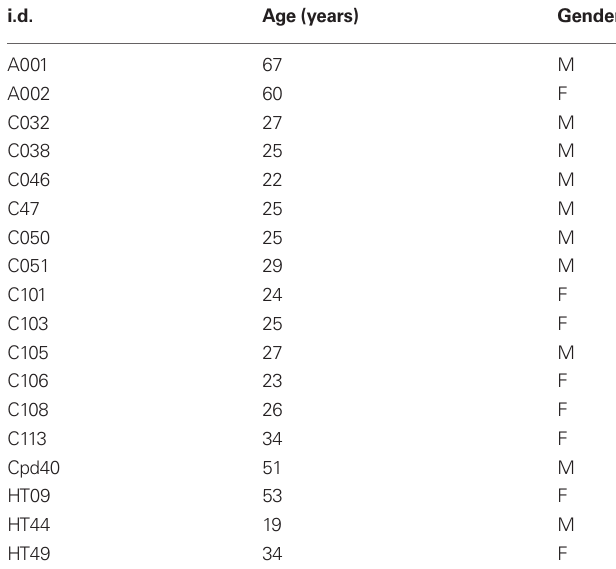
Table 2 | Control subjects demographics.